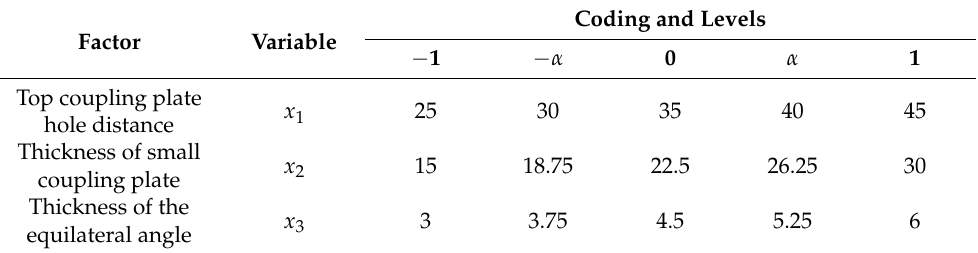
Table 5. Design factor coding and levels.